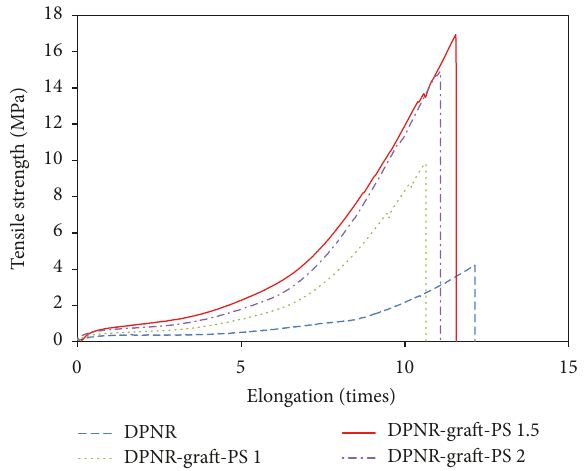
Figure 4: Stress-strain curves of un-vulcanized DPNR and various DPNR- graft